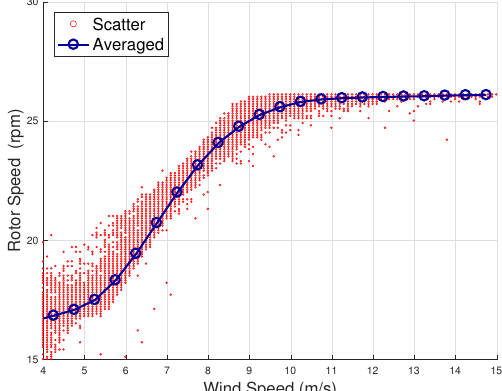
Figure 2. A sample scatter and binned wind speed—rotor speed curve for WF2.